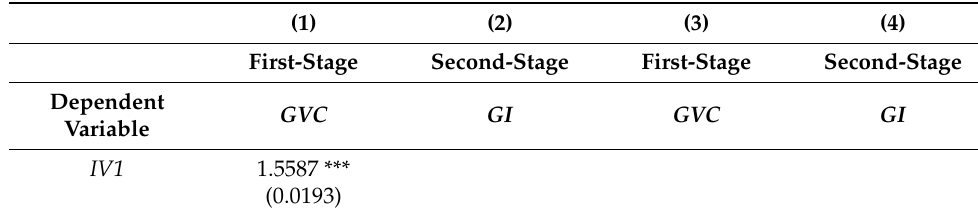
Table 3. Robustness checks II: 2SLS